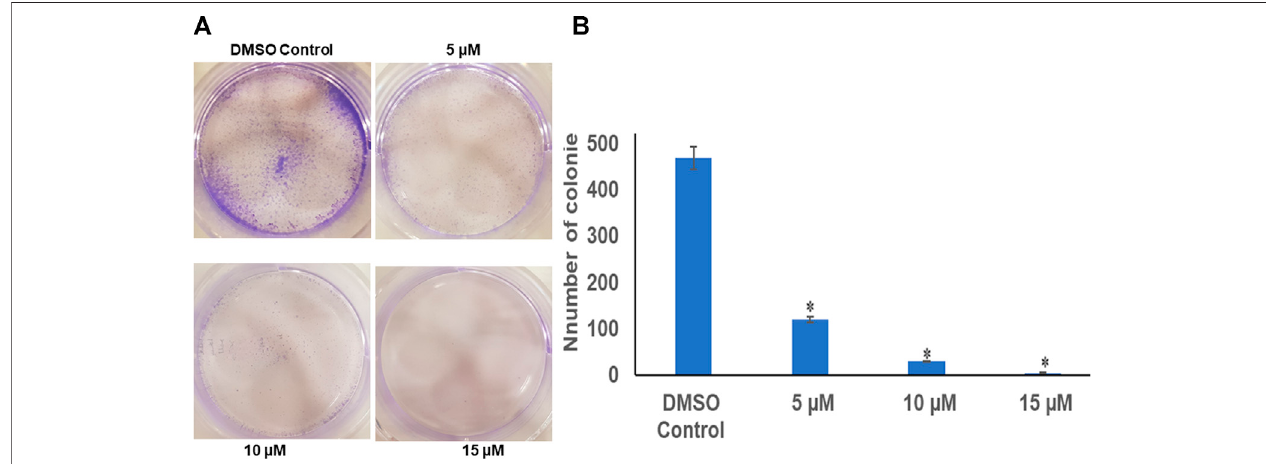
FIGURE 2 | (A) Chrysin treatment prevented migration of HeLa cells, as compared to the DMSO control wells, the chrysin treatment showed increase in wound width after 10 – 15 µM treatment. (B) Graphical representation of increase in wound width after chrysin treatment at 10 – 15 µM concentrations for 24 – 48 h. (C) The chrysin-treated HeLa cells depicted signi fi cant decrease in cell migration using trans-well inserts. (D) Graphical representation of inhibition of cell migration by